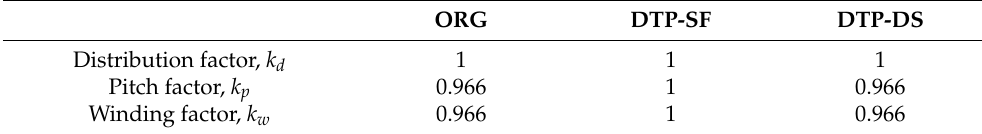
Table 4. Winding factors of different winding configurations.